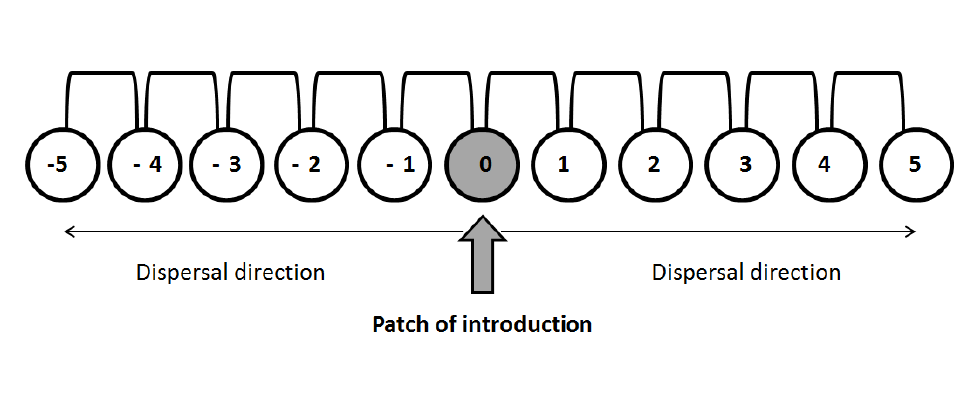
Figure 3 – Experimental system: 11 plastic tubes connected with pipes to form a one dimensional stepping-stone landscape. Population can spread on both sides of the intro- duction patch. The propagation speed is computed as the number of colonized patches on one side divided by the number of